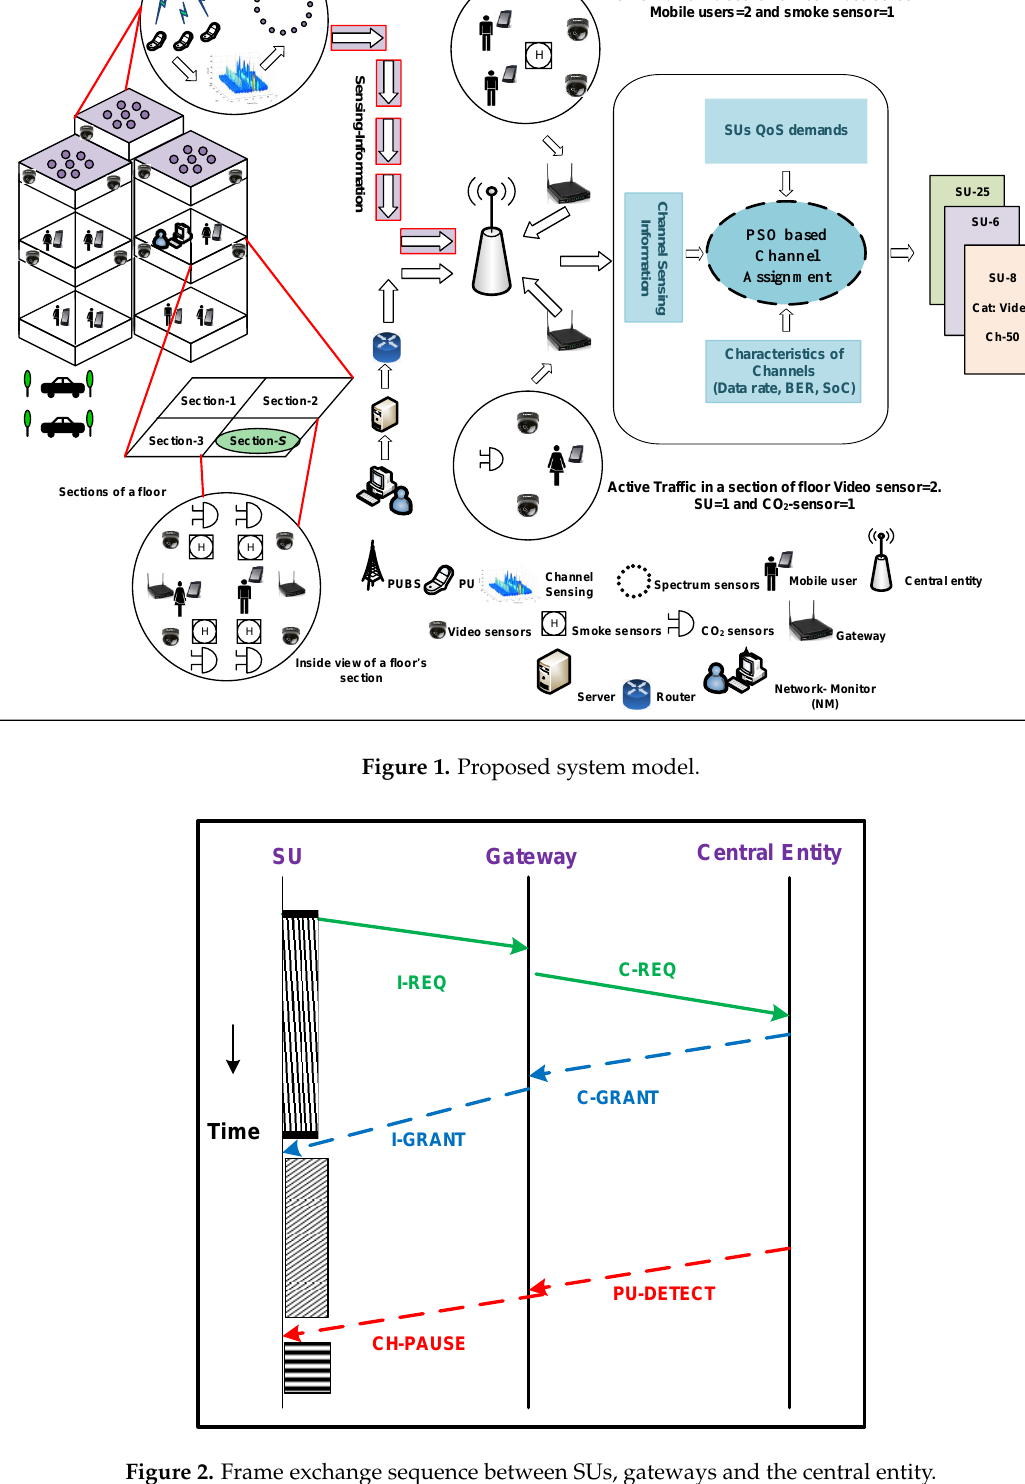
Figure 2. Frame exchange sequence between SUs, gateways and the central